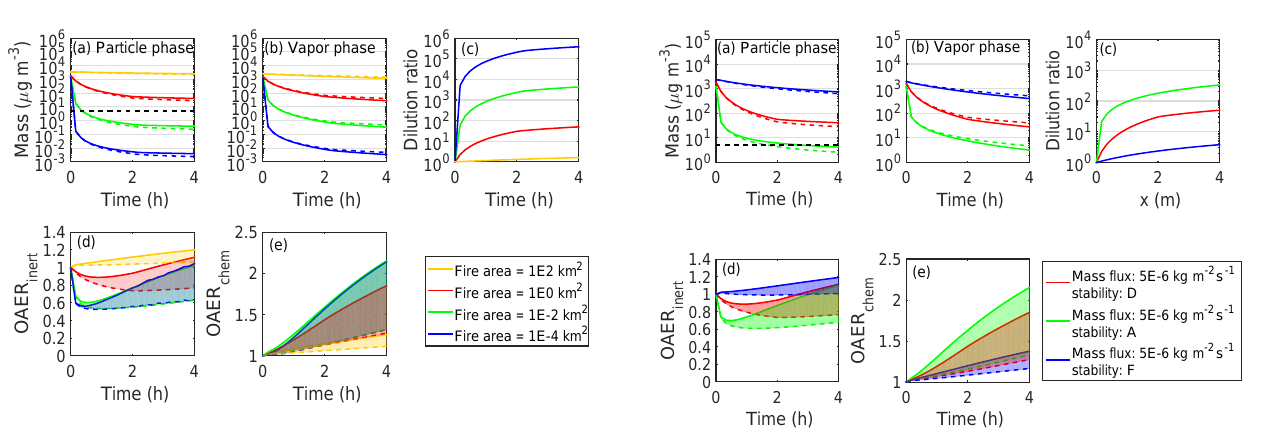
Figure 6. Time evolution of (a) organic mass (OM) in the particle phase, (b) OM in the vapor phases, (c) dilution ra- tios, (d) OAER inert , and (e) OAER chem during Gaussian dis- persion, using the parameters listed in Table 3 with fire areas of 100, 1, 1 × 10 − 2 and 1 × 10 − 4 km 2 and an emission flux of 5 × 10 − 6 kgm − 2 s − 1 . Solid lines represent the upper-bound- chemistry simulations and dashed lines represent the lower-bound- chemistry simulations. Shaded areas bound the ranges of estimated OA enhancement. The black dashed line on panel a represents the background nonvolatile OA concentration (5µgm − 3 ) .